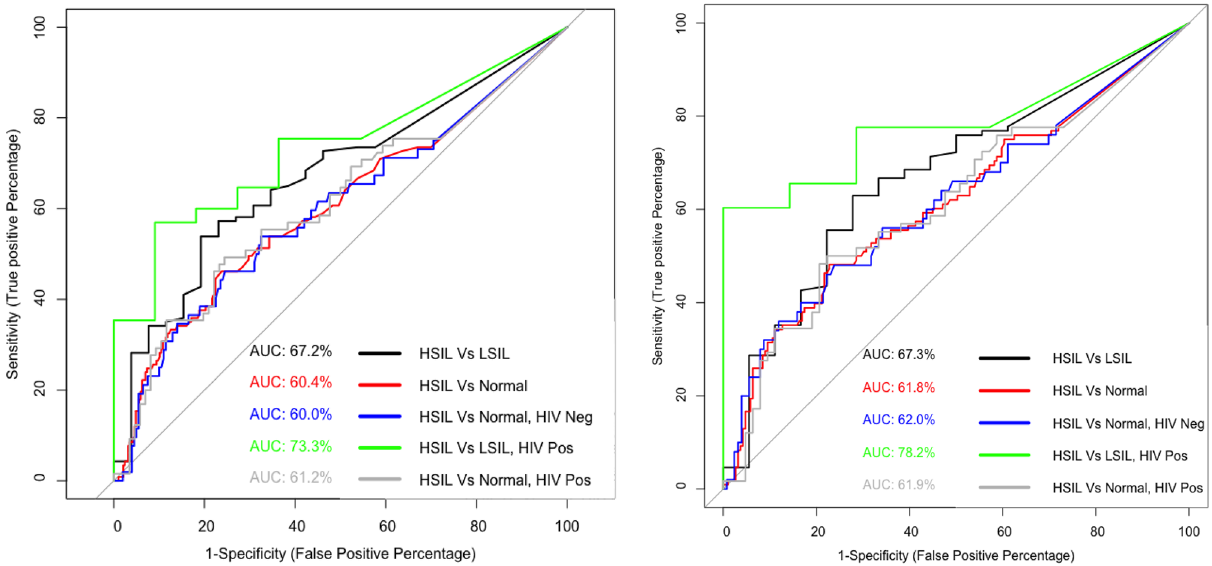
Figure 2. Receiver Operating Characteristic (ROC) curve for the percentage methylation of gene CADM1 for all significant (p, ≤ 0.05) comparison combinations identified in the nonparametric Wilcoxon test. Comparisons include HSIL versus LSIL (black), HSIL versus Normal (red), HSIL versus Normal HIV negative (blue), HSIL versus LSIL HIV positive (green) and HSIL versus Normal HIV positive (grey). ( A ) HRHPV positive and negative samples ( B ) HRHPV positive samples